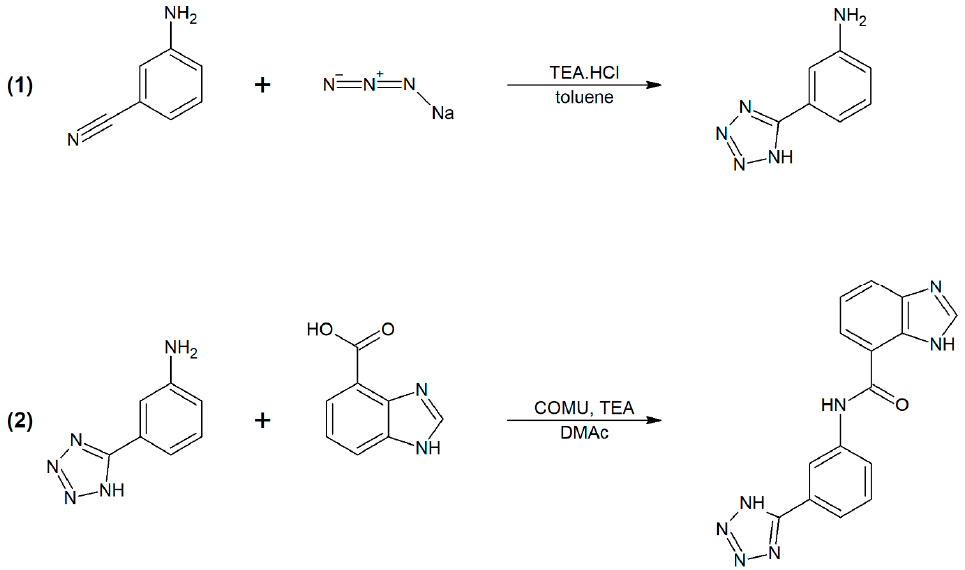
Figure 5. Two-step synthesis of G3K.